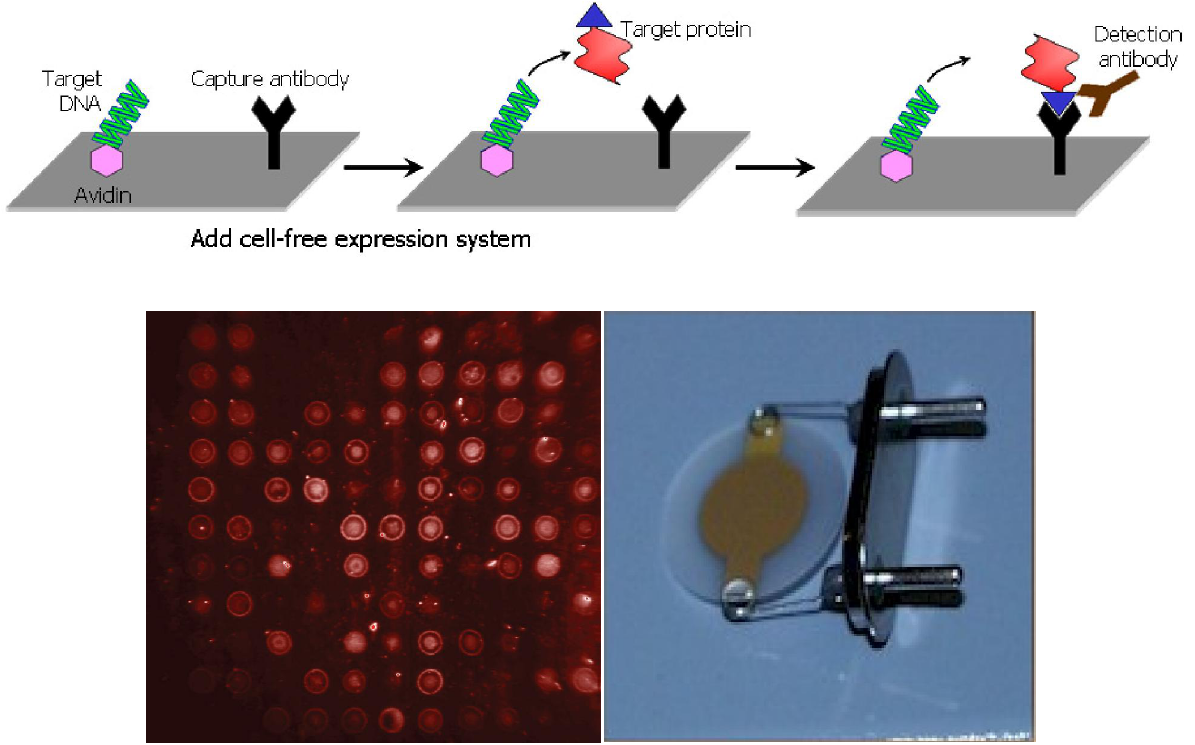
Figure 9. Above: NAPPA technology [103]. Below left: NAPPA region image with human kinase proteins acquired by the DNASER device. Below right: Multi-nanogravimetry quartz crystals for biosensor will consist of four gold coated quartz crystals 8 mm wide on which will be spotted NAPPA genes in the geometry previously adopted, i.e ., 16 spots (4 × 4)—each of 300 microns of diameter—spaced of 750 microns, center to